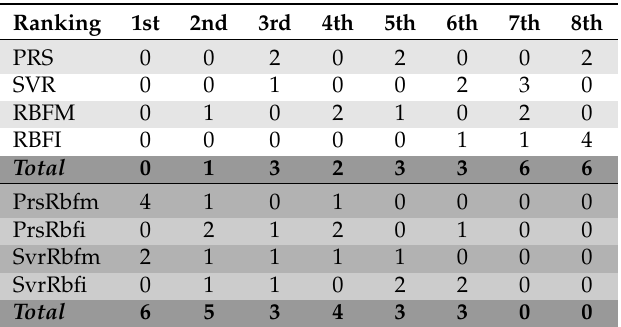
ranks 1st for all the benchmark problems; (3) in Scheme 3, SvrRbfm ranks 1st for four benchmark problems and 2nd for two benchmark problems; although RBFM ranks 1st for two benchmark problems, it is the worst performer for three benchmark problems; (4) in Scheme 4, without exception, the accuracy of SvrRbfi outperforms that of SVR and